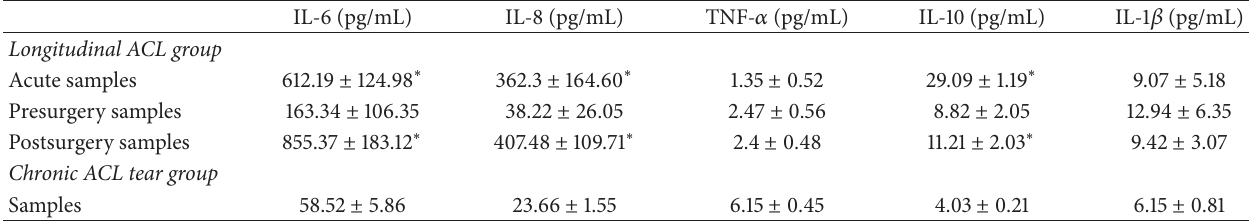
Table 1: Cytokine levels in synovial fluids from longitudinal ACL group and from chronic ACL tear